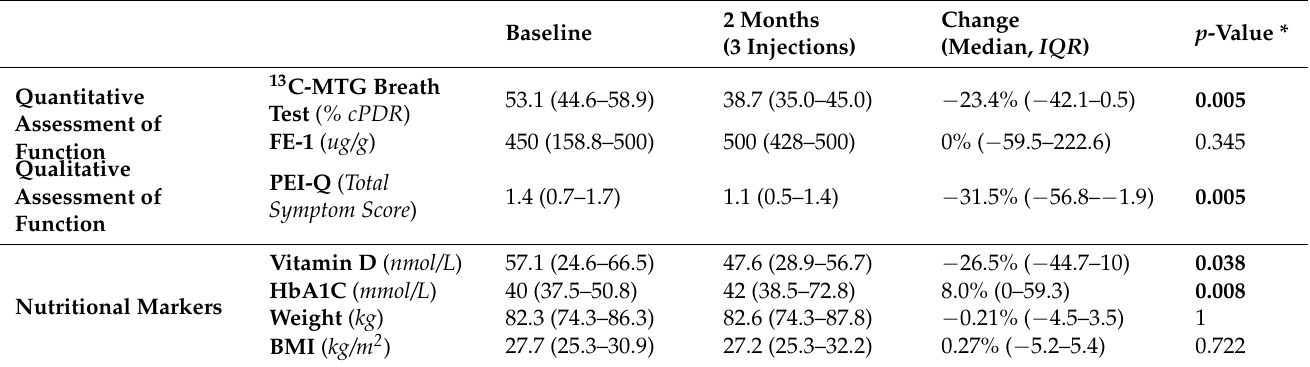
Table 2. Before and after SSA functional exocrine profile.